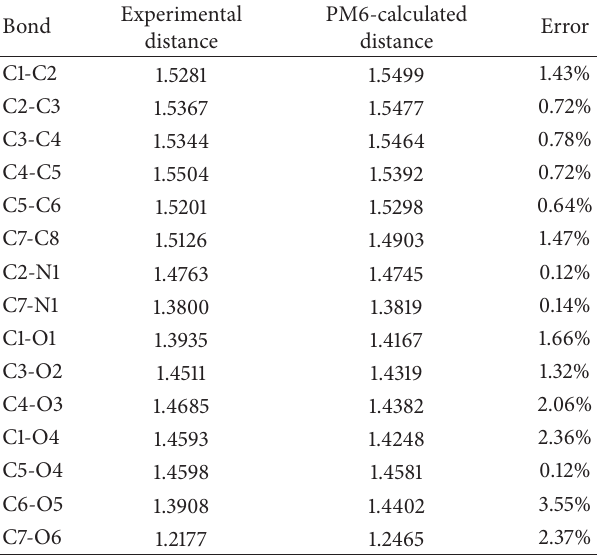
Figure 5: Comparison of the PM6 optimized geometry with the experimental X-ray geometry of N -acetyl-D-glucosamine. Table 1: Comparison of the experimental bond lengths (in ˚A) with those of the geometry optimized with the PM6 method. The unsigned mean error (UME) is 1.30%.